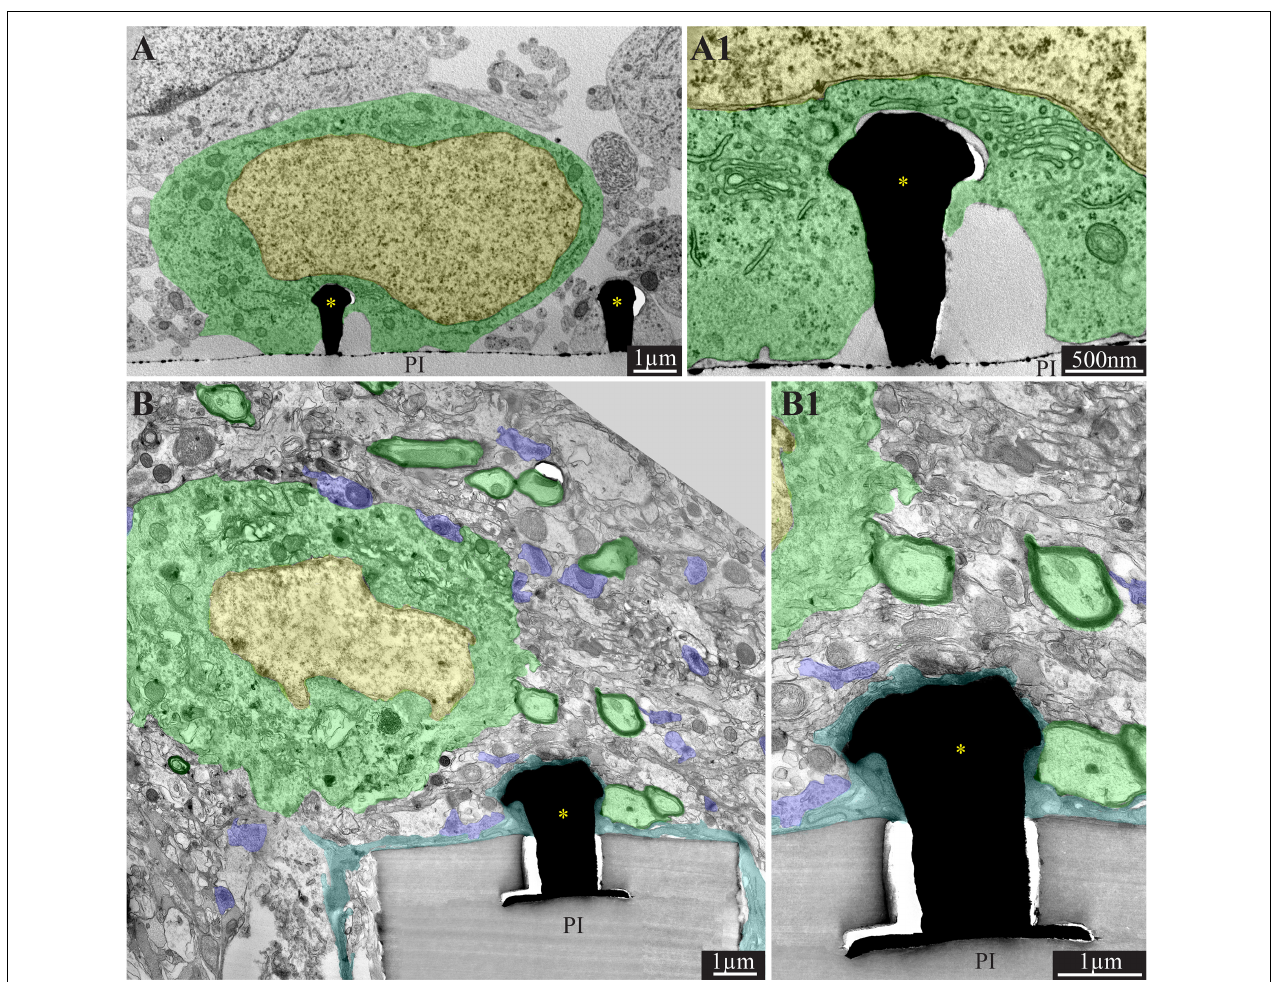
FIGURE 2 | Comparison of the ultrastructural interfaces formed between gold mushroom-shaped microelectrodes (gM µ E) and the cells around them in culture (A,A1) and under in vivo conditions (B,B1) . (A) In culture of primary rat neurons the neuron’s somata (green) engulf the gM µ E “cap’s.” The narrow cleft formed between the neurons plasma membrane is free of other cells types (A1) . (B) In contrast, under in vivo conditions, the gM µ E are insulated by thin layer(s) of dark microglia. In addition a network of regenerating neurites and astrocyte branches occupy the space between the neurons and the gM µ E (see also schematics